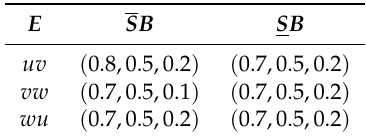
Table 10. Neutrosophic soft rough set on E